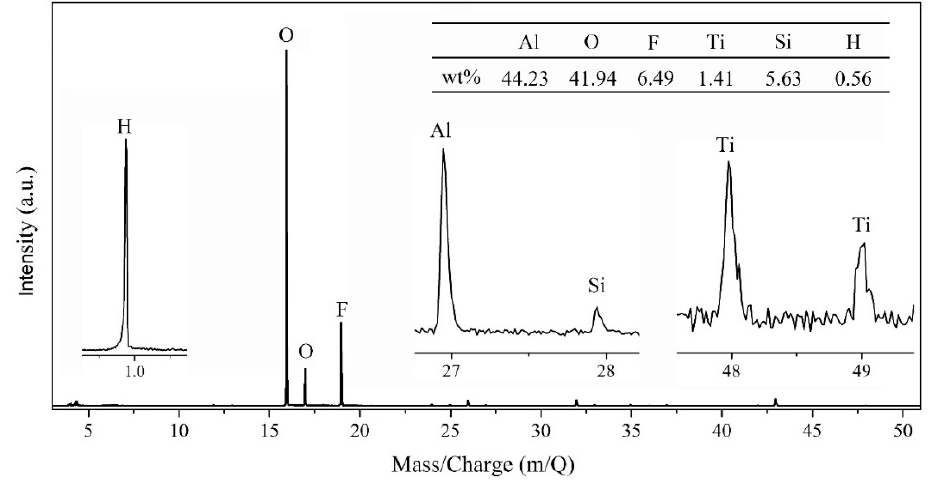
Figure 4. TOF-SIMS for quantificationally determining the elements including Al, Ti, Si, C, O, and H of the coating.